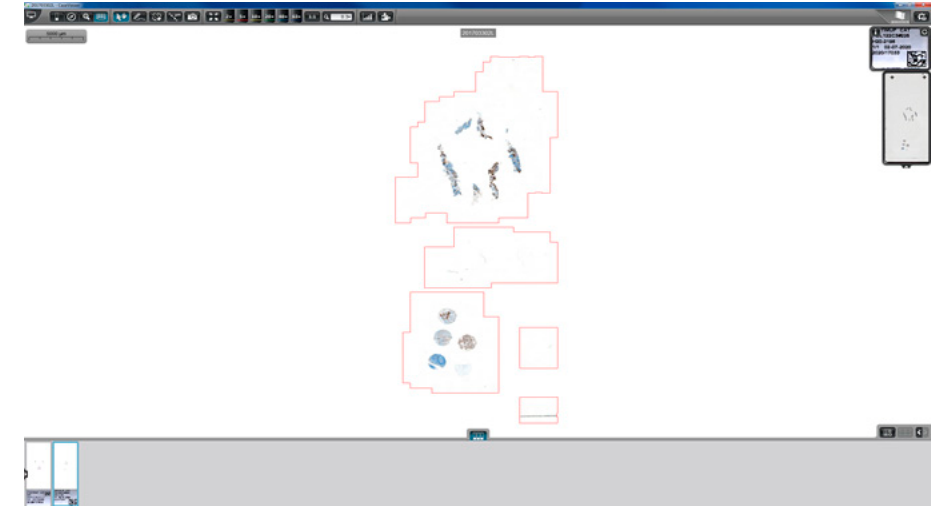
Figure 4. Print screen of a whole slide image representing an immunohistochemistry staining of a specimen together with the set of 5 control tissue microarrays for routine utilization.